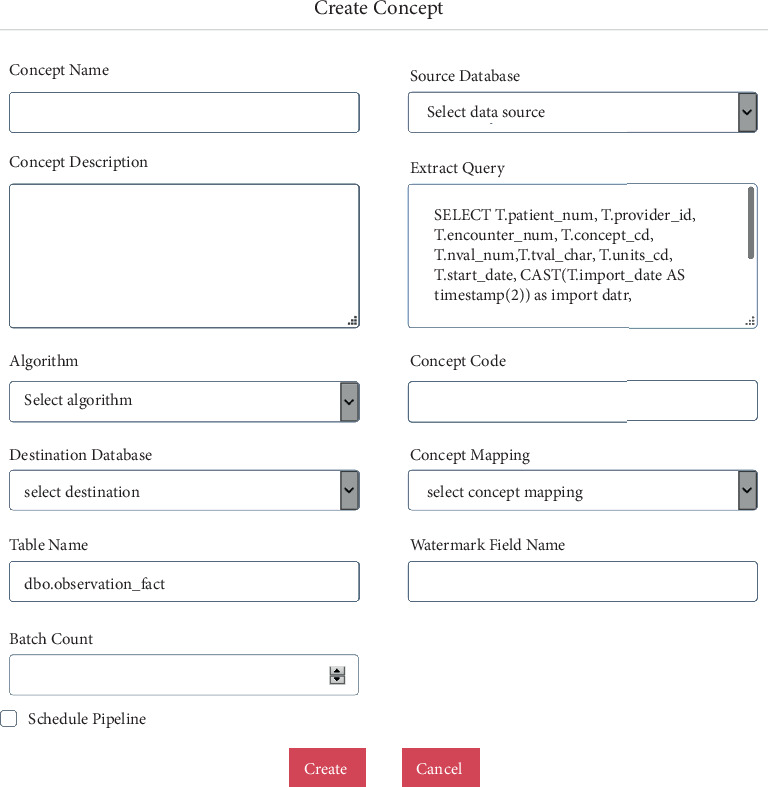
Creating a concept.